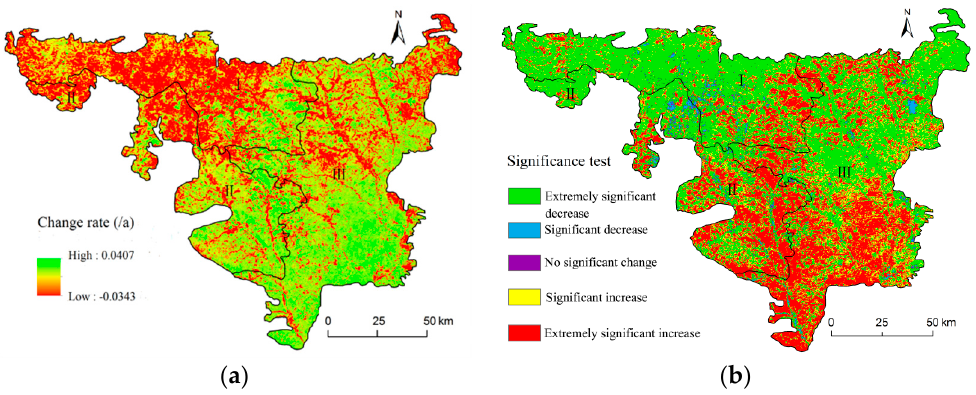
Figure 6. Spatial change rate ( a ) and significance tests ( b ) of fractional vegetation coverage in the Pisha Sandstone area.